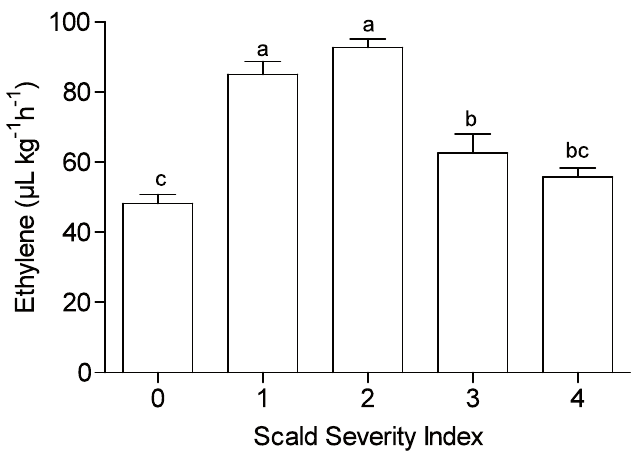
Fig. 2: Ethylene production in ‘Granny Smith’ apples with different scald severity. The data are the means ± standard error (SE) of six re- plicates with five fruits per replicate. Different letter(s) on the bars mean statistical differences according to Duncan’s multiple range test